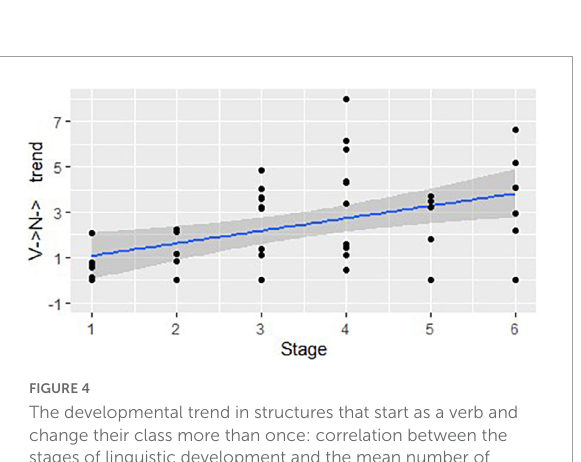
FIGURE4 The developmental trend in structures that start as a verb and change their class more than once: correlation between the stages of linguistic development and the mean number of structures used in each DCP (represented by dots), per 100